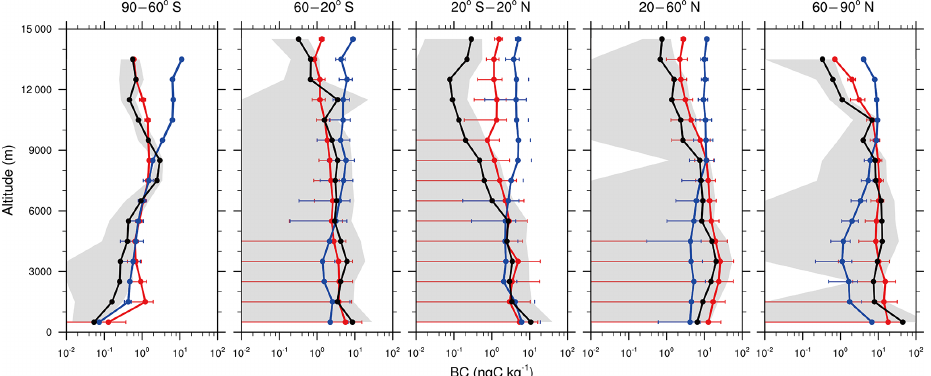
Figure 5. Comparison of observed and simulated BC vertical profiles during HIPPO missions for the latitude bins of 90–60 ◦ S, 60–20 ◦ S, 20 ◦ S–20 ◦ N, 20–60 ◦ N and 60–90 ◦ N. Black lines and shaded areas show the means and standard deviations of the observations binned in 1km intervals, respectively. The colored vertical lines and horizontal bars show the means and standard deviations of the default (blue) and modified CAM5 results (red),